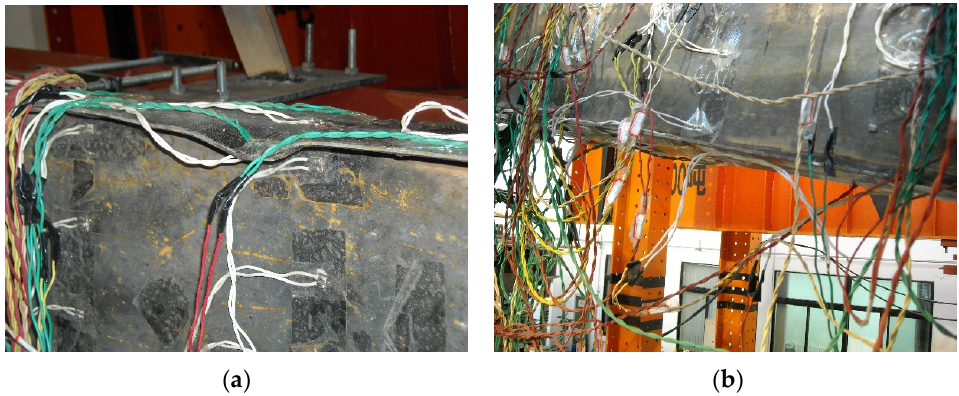
Figure 8. Failure phenomenon of specimen SV2. ( a ) Local buckling of the upper flange; ( b ) Local buckling of the lower flange.